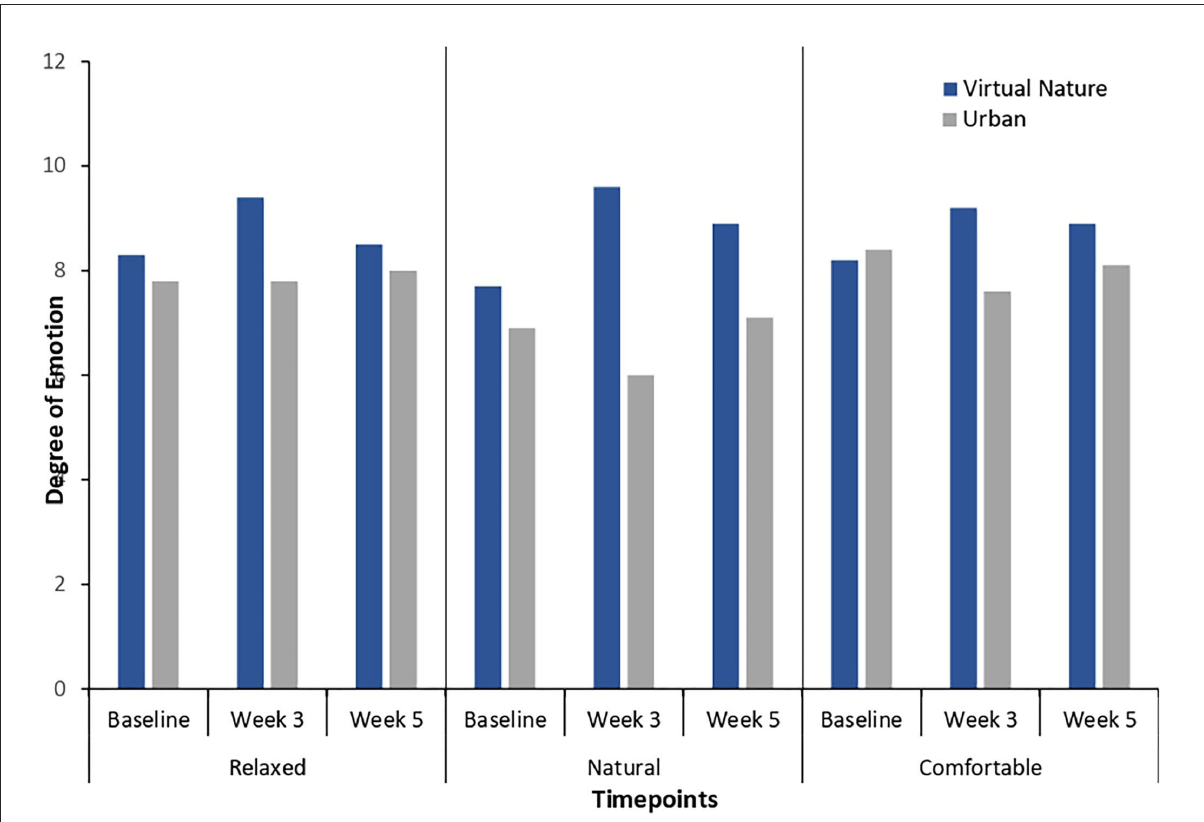
FIGURE4 Degree of relaxed, natural, and comfortable mood at baseline (T0), week 3 (T1), and week 5 (T2) in the virtual nature group and urban group. The increase in relaxed, natural mood in week 3 from the baseline in the virtual nature group reached statistical significance. Although there was a trend of increase in comfortable mood in week 3 from the baseline, that change was not statistically significant. Moreover, the levels of relaxed, natural, and comfortable mood in the virtual nature group were higher than those in the urban group in week 3. Although the differences did not reach statistical significance, there was a greater trend of a more relaxed and comfortable mood in the virtual nature group than in the urban group at the week